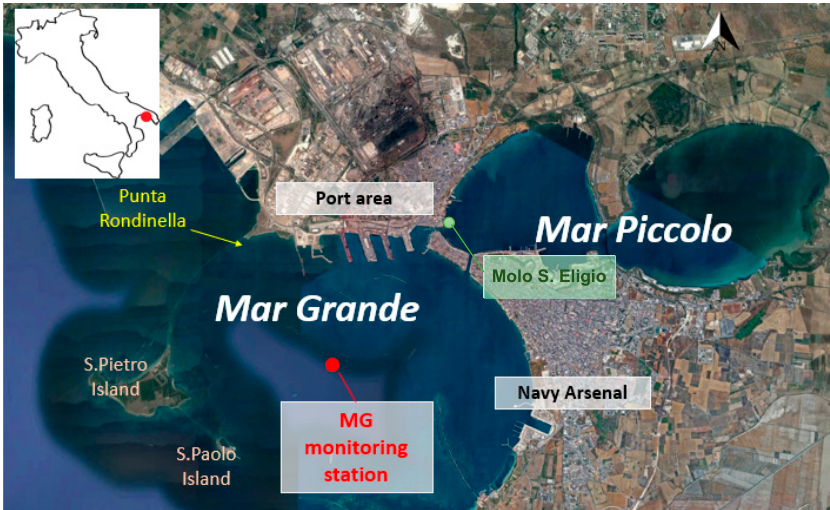
Figure 1. Map of Mar Grande basin and location of the monitoring station MG.